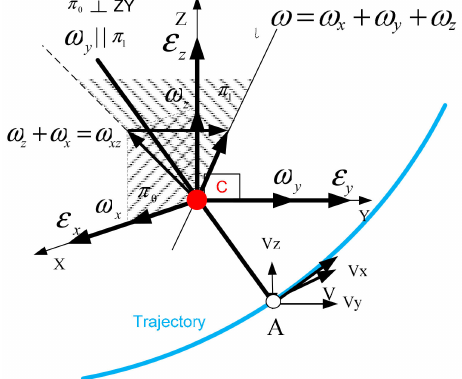
→ V relative to the coordinate system → ω relative to the → r relative to the